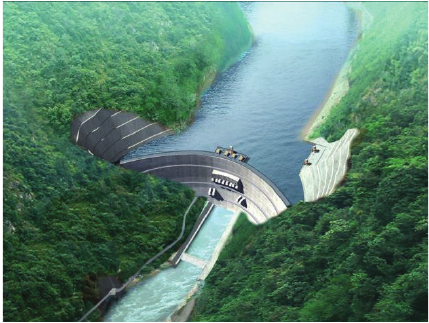
Figure 1: Survey of the Dagangshan Hydropower